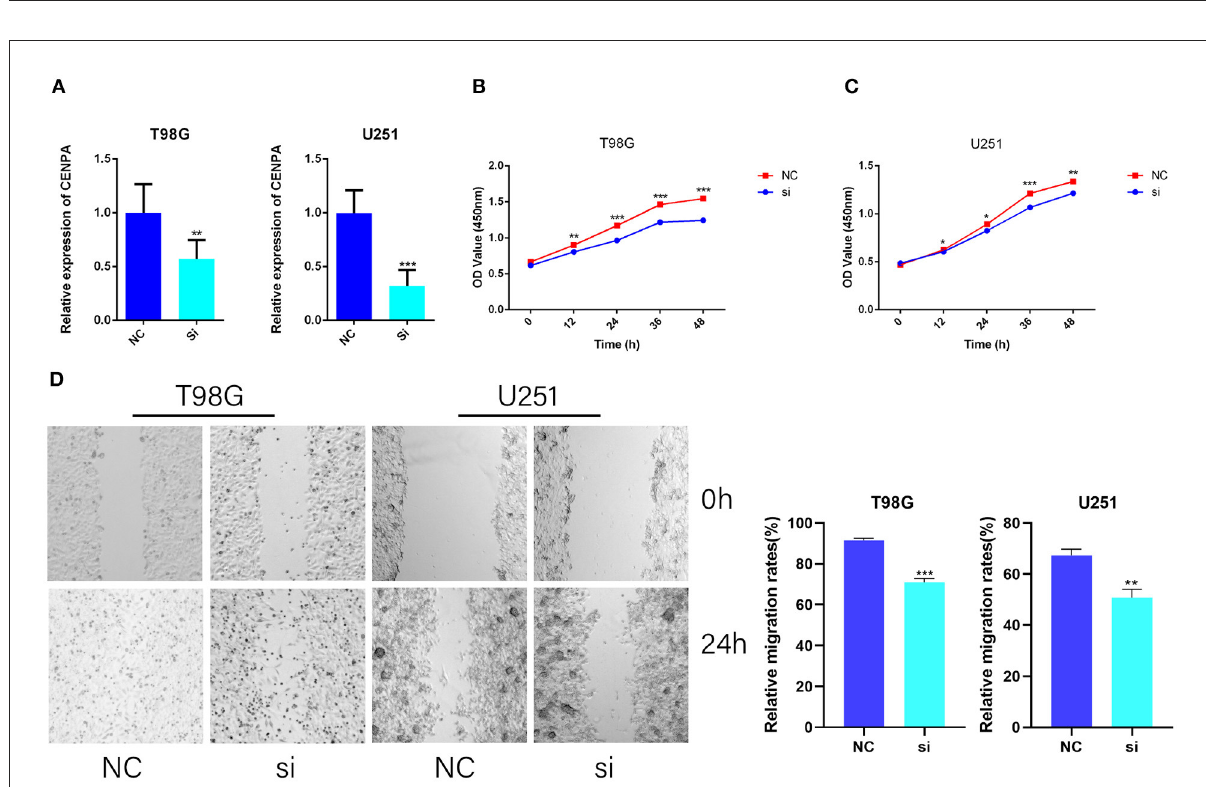
FIGURE3 CENPA promotes T98G and U251 cell viability and migration. T98G and U251 were transfected with CENPA-siRNA and NC, respectively. (A) siRNA effectively inhibits the expression of CENPA in U251 cells and T98G cells. (B,C) Cell viability was measured by the CCK8 assay in T98G